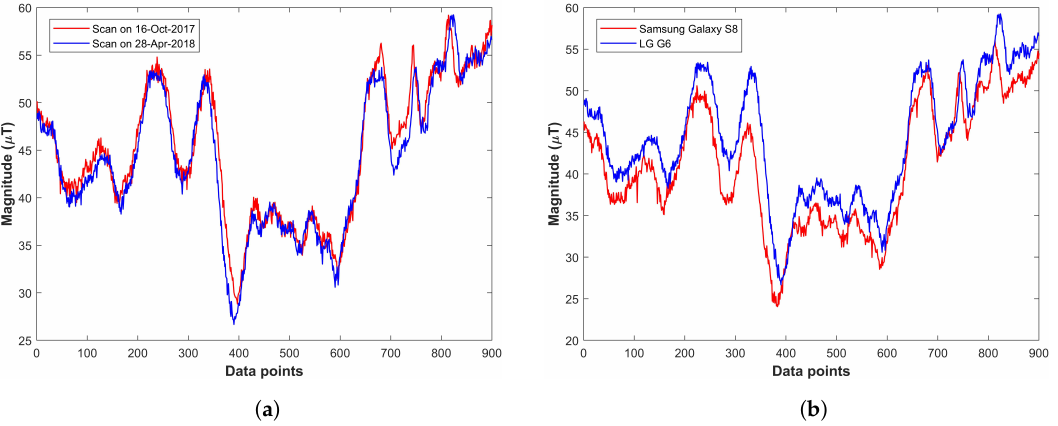
Figure 6. Magnetic field attitude over various time and smartphones, ( a ) on different dates with the same smartphone, ( b ) various smartphones at the same